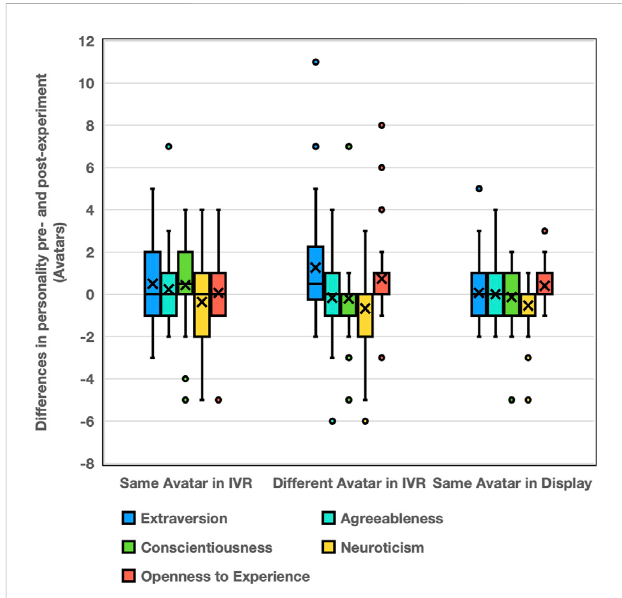
FIGURE 3 Differences in avatar ’ s personality pre- and post-role-play (G1: